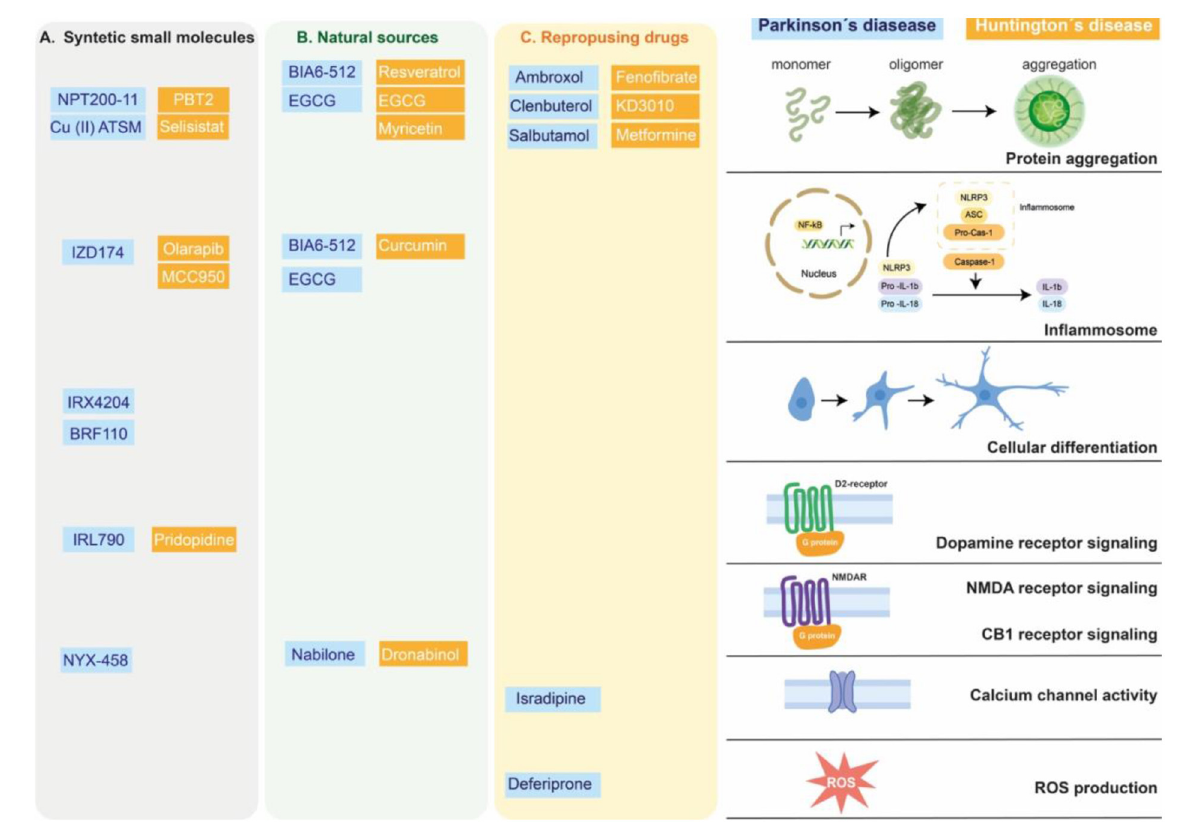
FIGURE1 Targets of small molecules in neurodegenerative motor disorders. Synthetic small molecules (A) , small molecules from natural sources (B) or Repurposing FDA-approved drugs (C) used to alleviate clinical symptoms of Parkinson’s disease (blue box) or Huntington’s disease (orange box). These molecules participate in modified specific cellular pathways related to alleviating or delaying the neurodegenerative process, as protein aggregation, inflammatory response (inflammosome), cellular differentiation, G protein coupled receptor, calcium channel activity or reactive oxygen species (ROS)